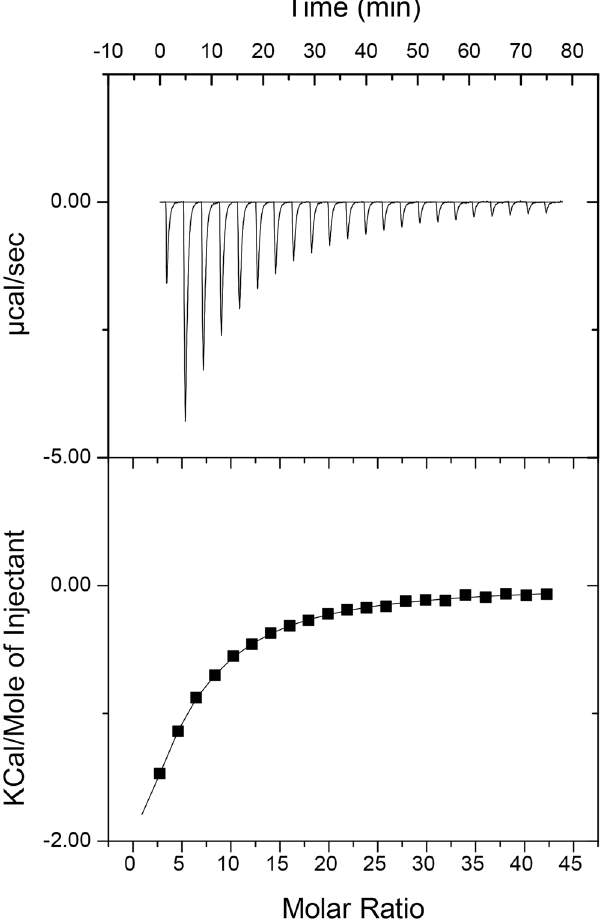
Figure 5. Isothermal titration calorimetric determination of the affinity of Mitsuba-1 for N-acetyl galactosamine. Fitting to a single-site model with stoichiometry of three sugar ligands to one protein molecule yields a K d value of 0.33 mM. Binding is modestly exothermic under the conditions used, with Δ H of − 6.5 kcal/ mol, but weakened by the entropy change of − 5.8 cal/mol/K.